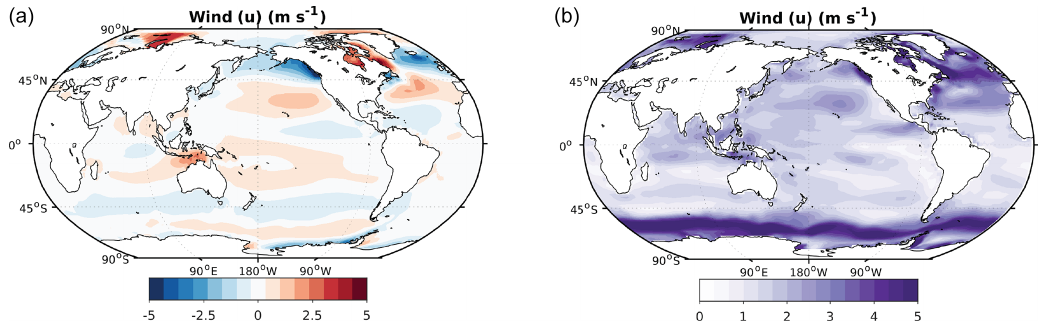
Figure 6. Annual mean zonal wind velocity lgm–piControl anomaly (a) and model spread (b) (in ms − 1